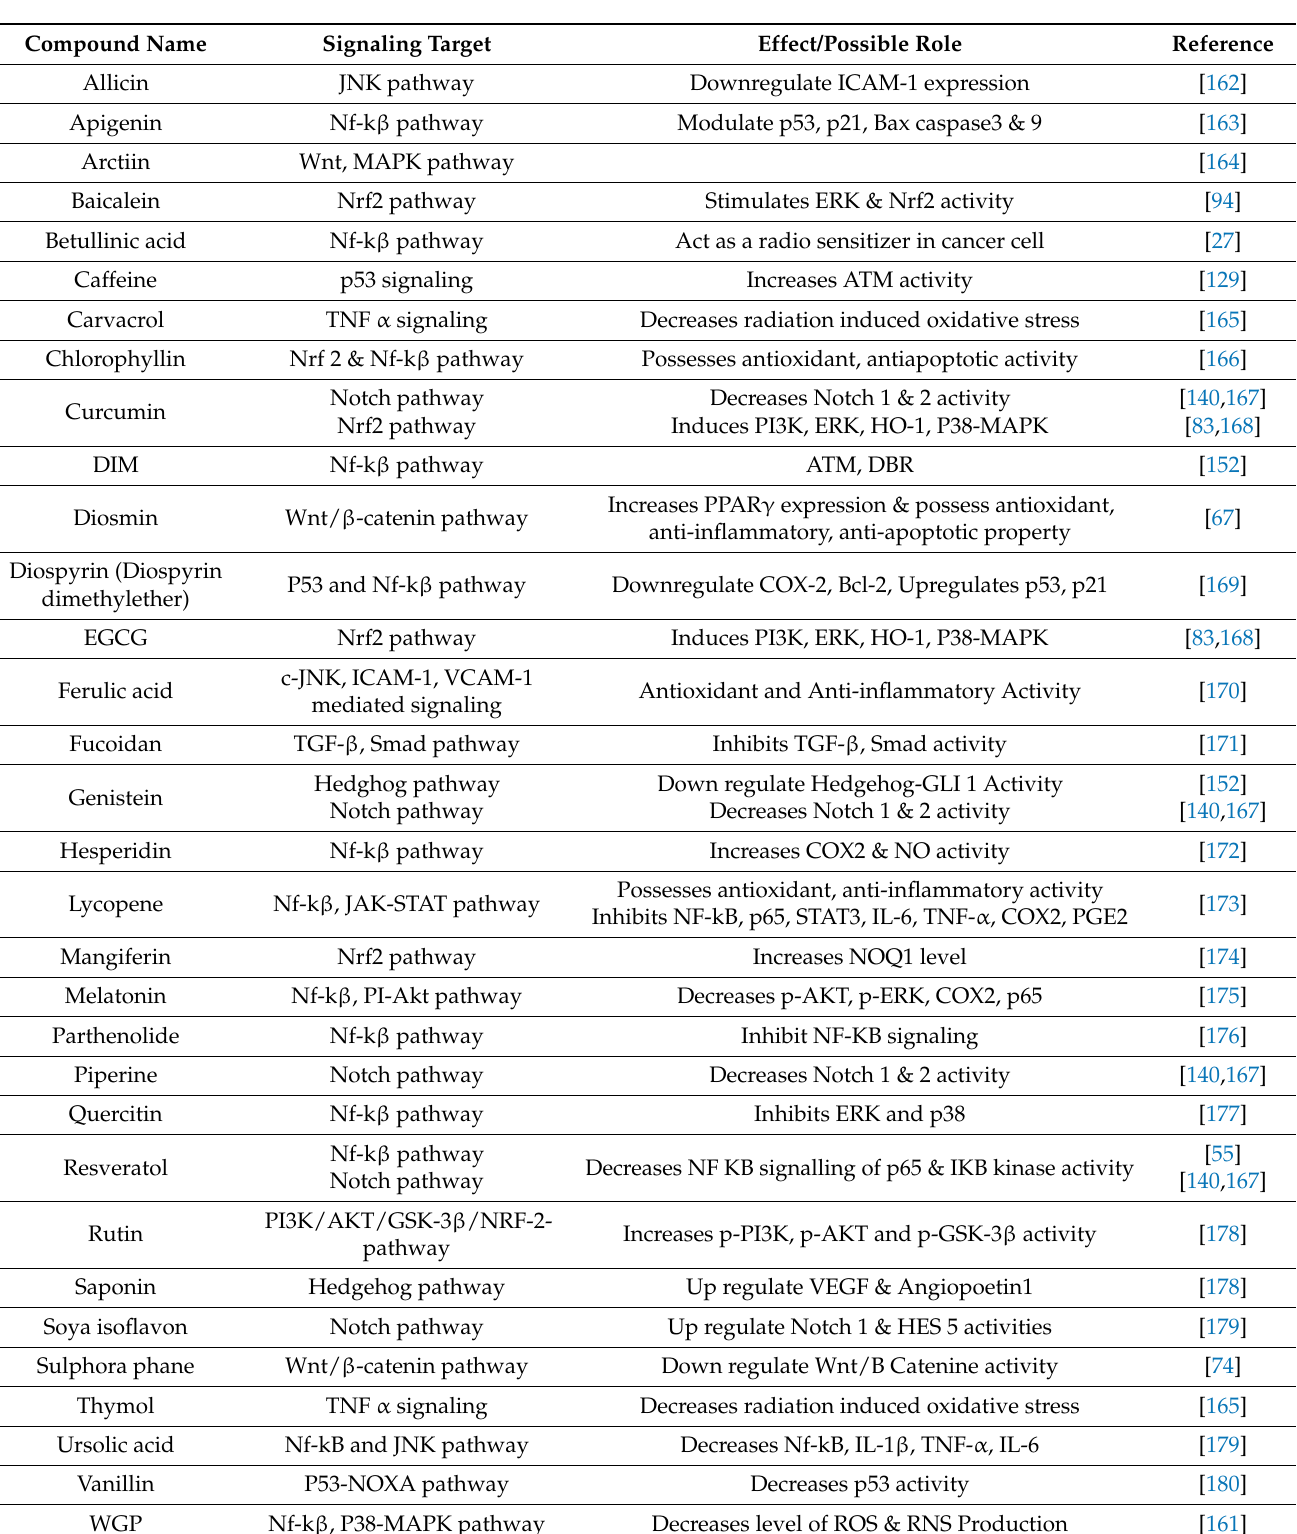
Table 1. Effect of phytocompounds and their possible role in radioprotection via different Signaling